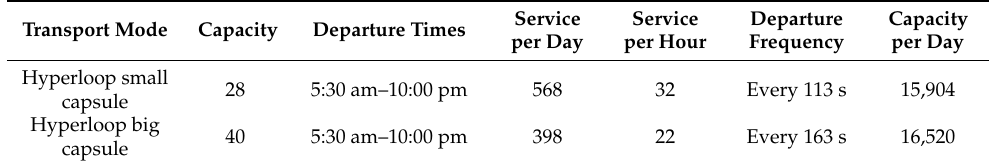
Table 2. Analysis of the passenger capacity for different capsule sizes